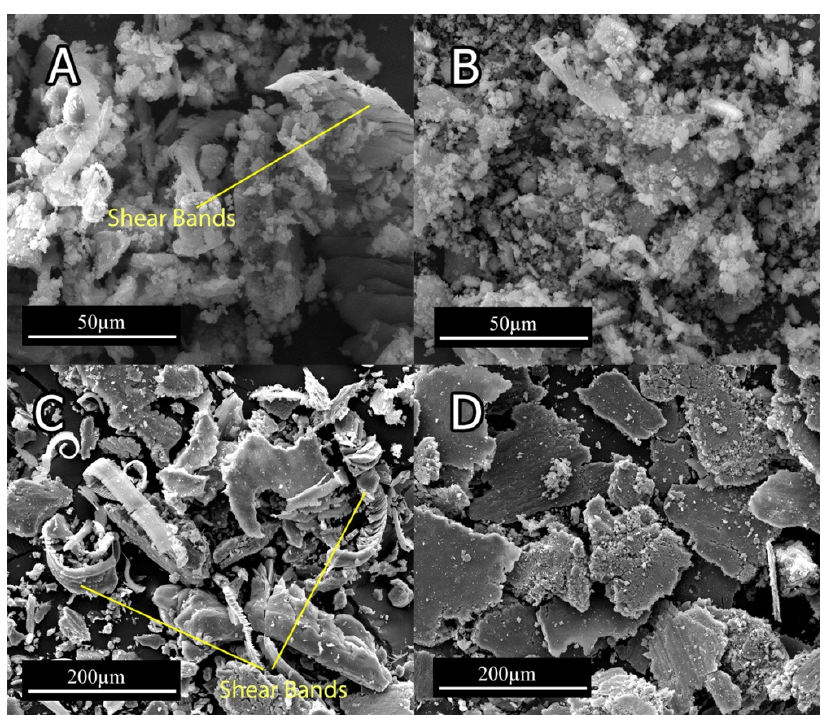
Figure 9. The wear debris of ( A ) 0Ti at 6 N; ( B ) 0.15Ti at 6 N; ( C ) 0.75Ti at 20 N; and ( D ) 1.5Ti at 20 N.